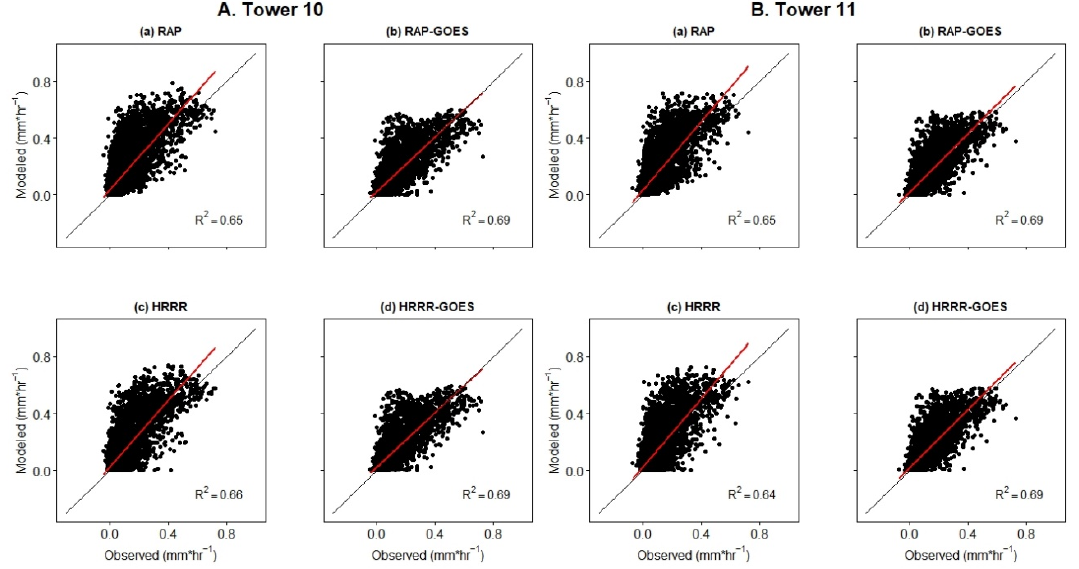
Figure 4. Scatter plots of observed vs. modeled actual evapotranspiration (AET) in the hourly time scale for Tower 10 ( A ) and Tower 11 ( B ) between May 2016 and April 2017. A black solid line indicates 1:1 line and a blue solid line represents a linear regression line.